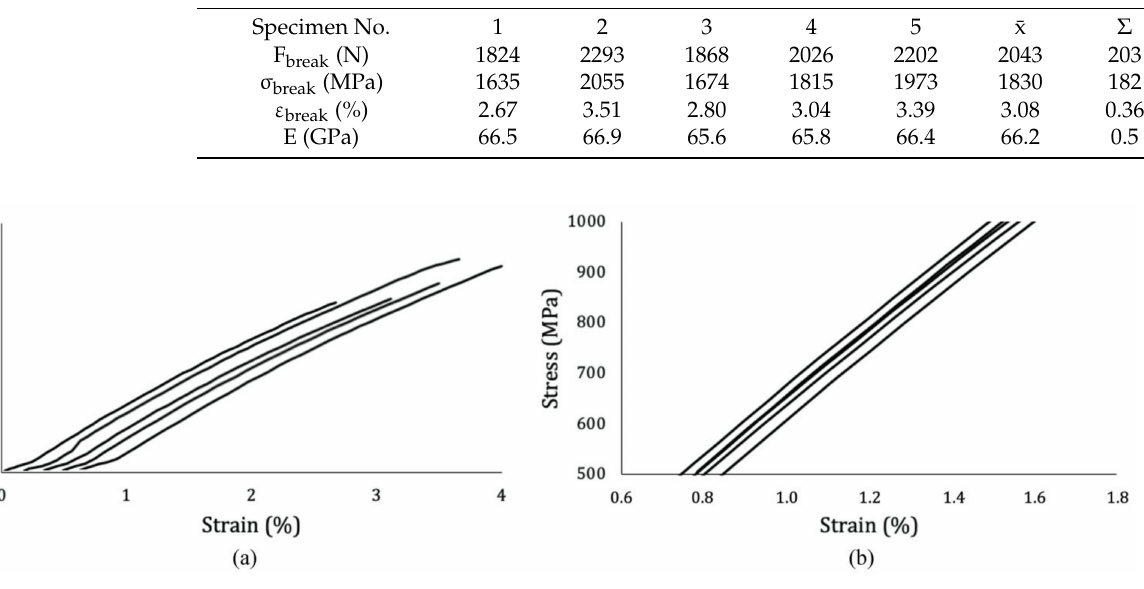
Figure 7. ( a ) Tensile test results of UHMWPE/LDPE tapes, specimens 1–5 (left to right) in offset; ( b ) post-slack zone considered for modulus calculation without